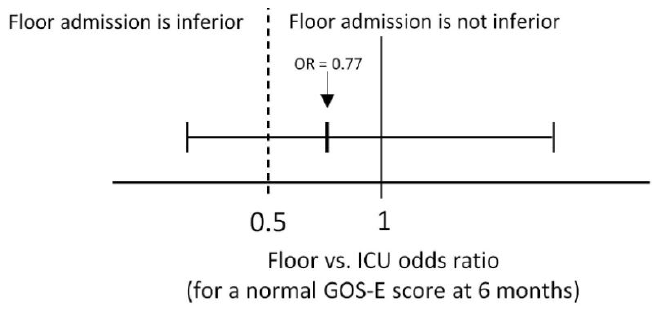
Figure 4. Adjusted odds ratio of floor admission on extended Glosgow Outcome Score (GOS-E) at six months (non-inferiority is not